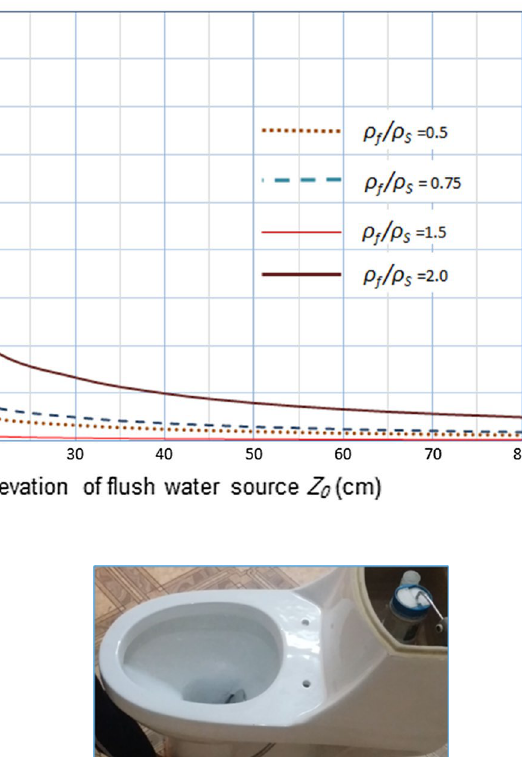
Fig. 2 Effect of flushwater source elevation and relative densities on relative mass of flushwater required